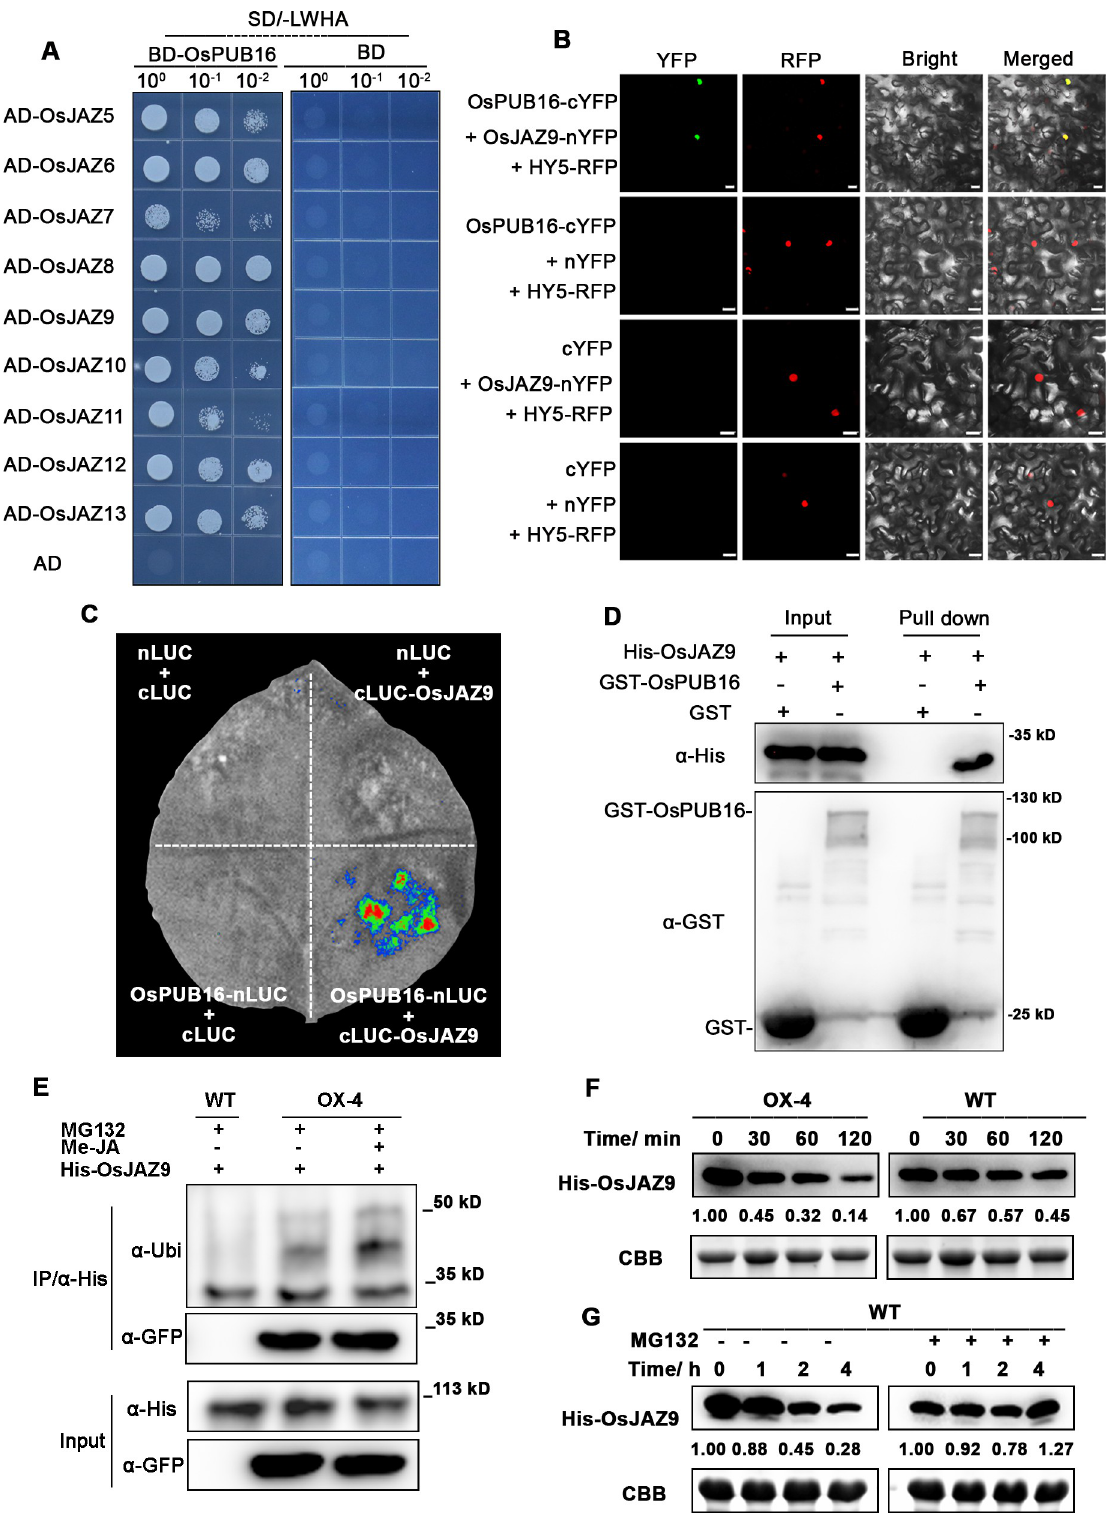
Fig 5. OsPUB16 interacts with rice JAZ proteins, and mediates ubiquitination and degradation of OsJAZ9. (A) Yeast two-hybrid assays to test the interaction of OsPUB16 with rice JAZ proteins. Yeast cells were grown on synthetic defined (SD)/-Ade-His-Leu-Trp (-LWHA) medium for 2 days. (B) Bimolecular fluorescence complementation (BiFC) assay for the interaction of OsPUB16 with OsJAZ9